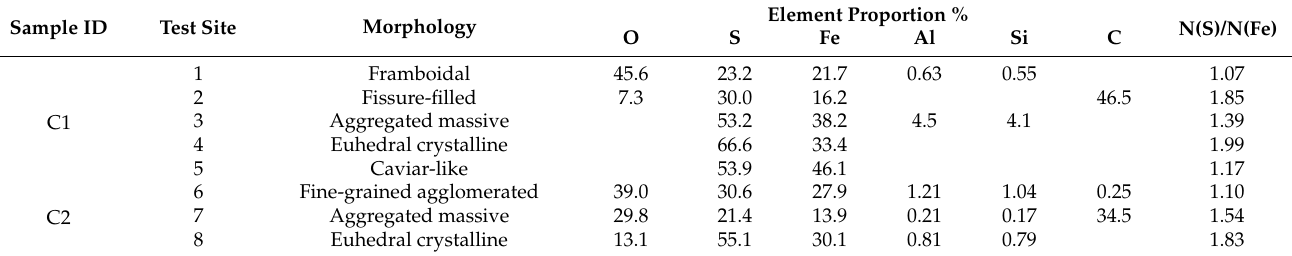
Table 2. Element content on the coal-pyrite samples/mole fraction